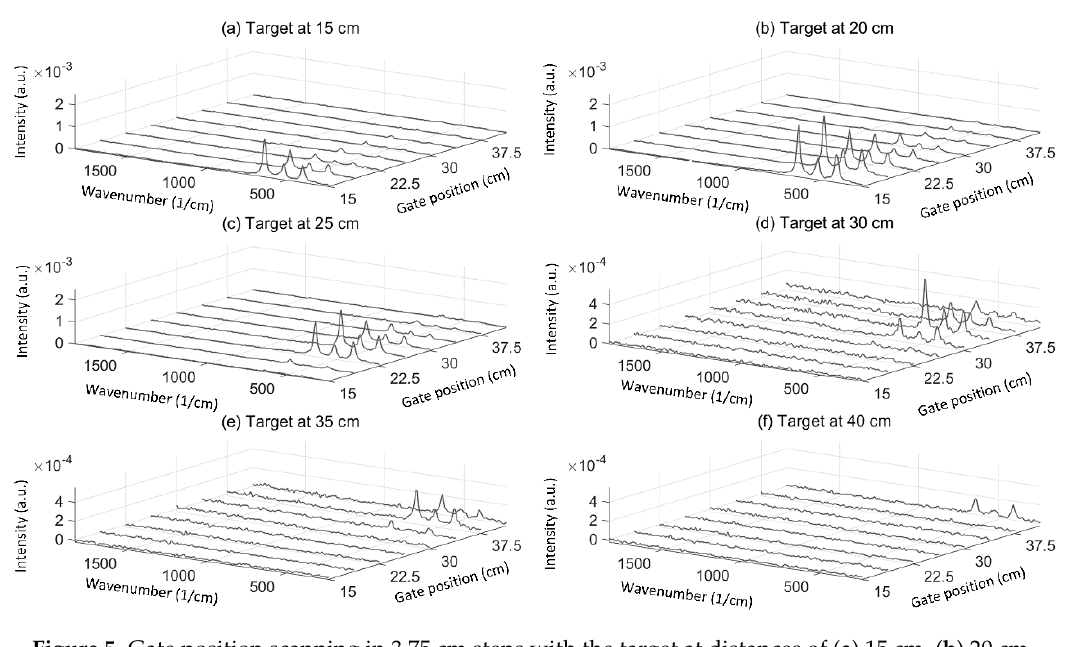
Figure 5. Gate position scanning in 3.75 cm steps with the target at distances of ( a ) 15 cm, ( b ) 20 cm, ( c ) 25 cm, ( d ) 30 cm, ( e ) 35 cm and ( f ) 40 cm.